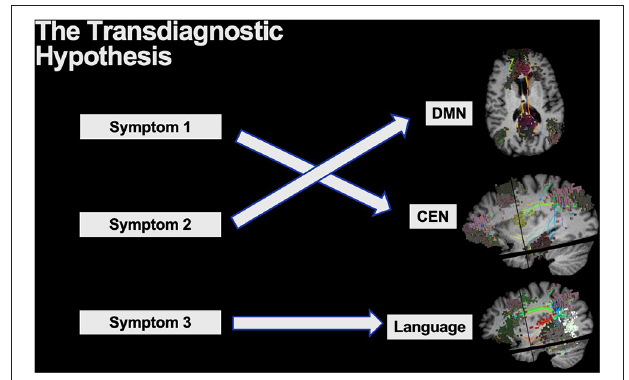
FIGURE 7 | The transdiagnostic hypothesis is often applied to explain the core psychopathological symptoms across a range of psychiatric disorders. Thus, while certain disorders may be clinically grouped together with vague classifications, unique symptoms likely localize to unique brain networks providing the need for addressing them